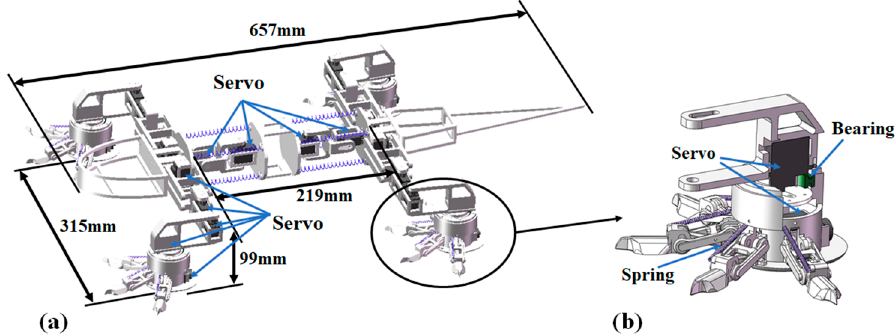
Figure 2. Desert lizard-inspired robot: ( a ) biomimetic structure and ( b ) break out section of